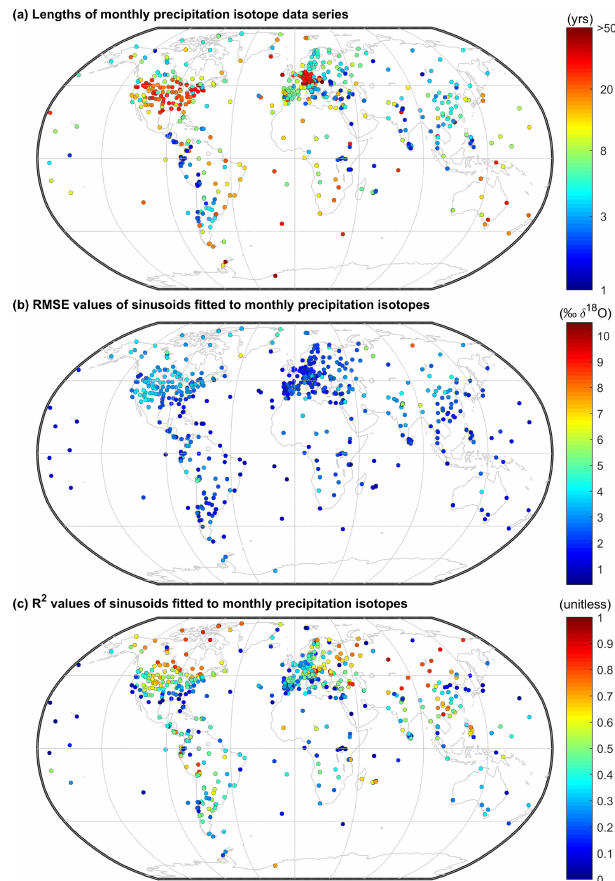
Figure 2. Maps of precipitation isotope measurement stations with colors indicating (a) the length of measurements at each site, and goodness-of-fit, statistics (b) root mean square errors (RMSEs) and (c) coefficients of variations ( R 2 ) of the fitting of sine curves to monthly, empirical time series from each station. We show the ro- bustly fitted δ 18 O statistics; the amount-weighted δ 18 O fit statistics, and the δ 2 H statistics (robustly fitted and amount-weighted) are pro- vided in the Supplement